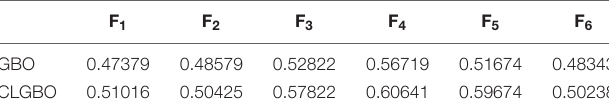
TABLE 4 | P -values of Wilcoxon rank sum test.